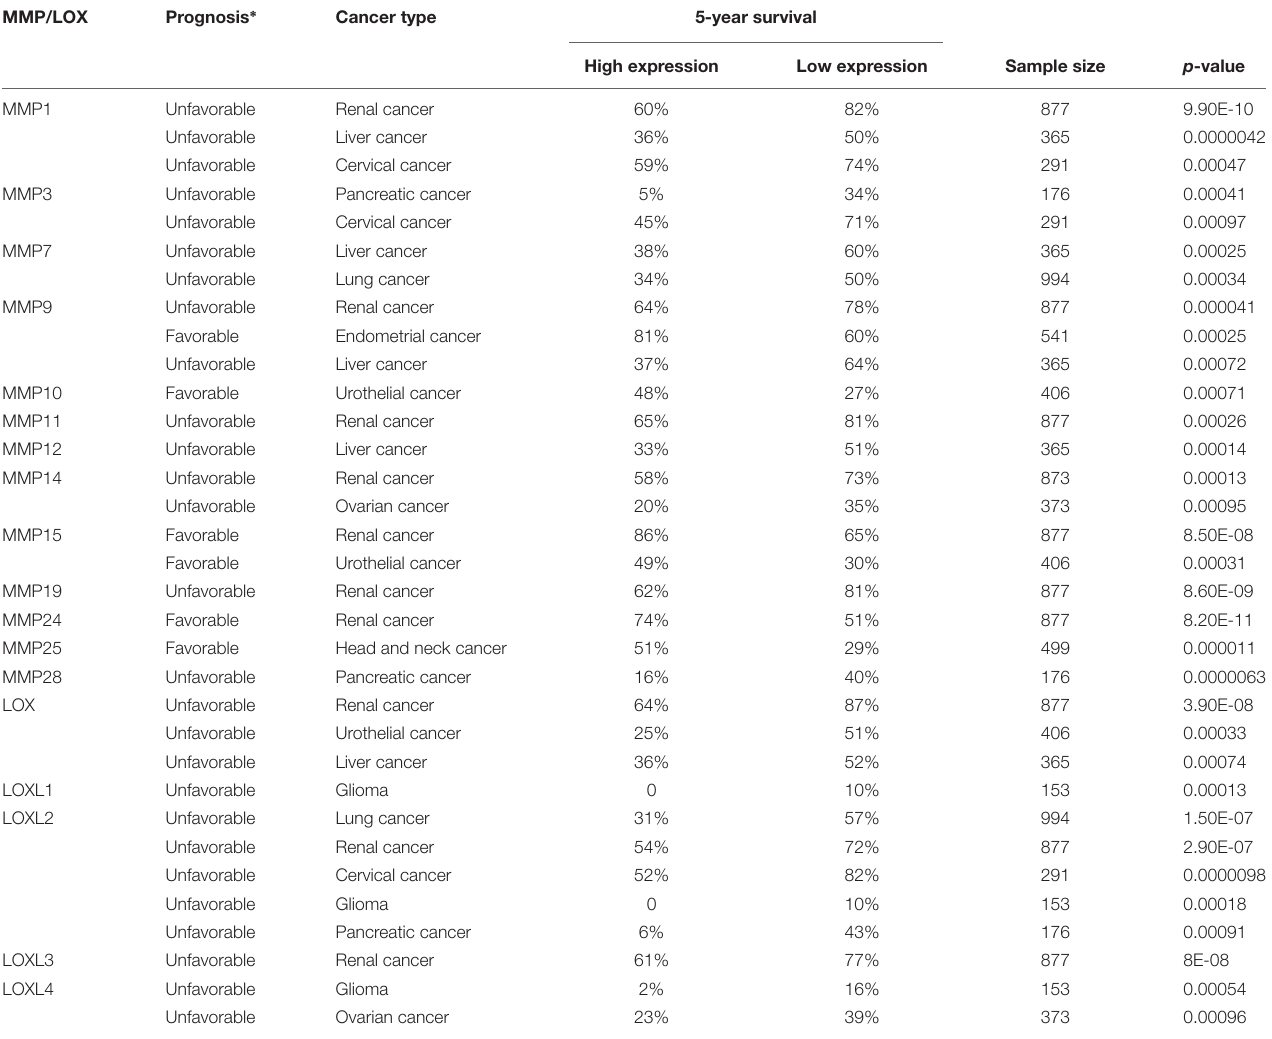
TABLE 2 | Correlations between MMP/LOX expression and the 5-year survival rates of cancer patients ∗∗ . MMP/LOX Prognosis